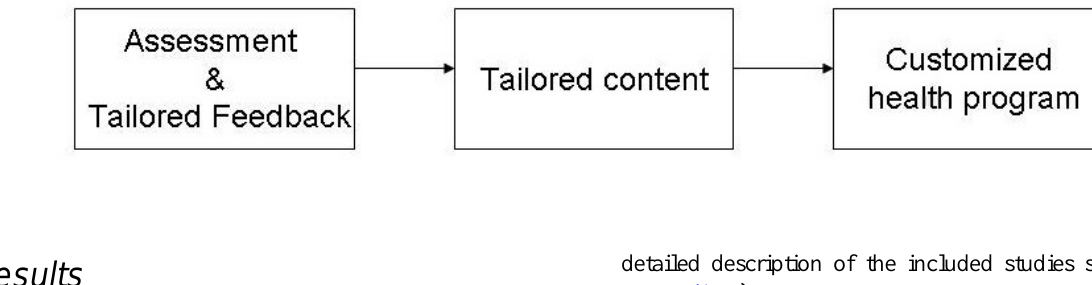
Figure 2. Continuum level of sophistication of tailored